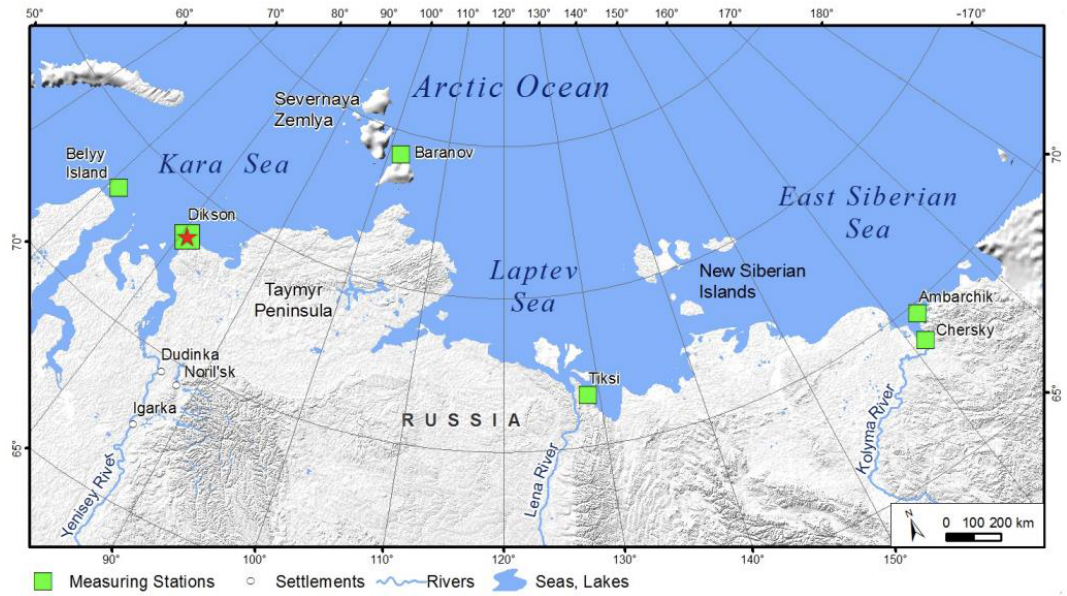
Figure 1. Network of stations continuously measuring atmospheric CO 2 and CH 4 mole fractions across the Arctic domain of Siberia.